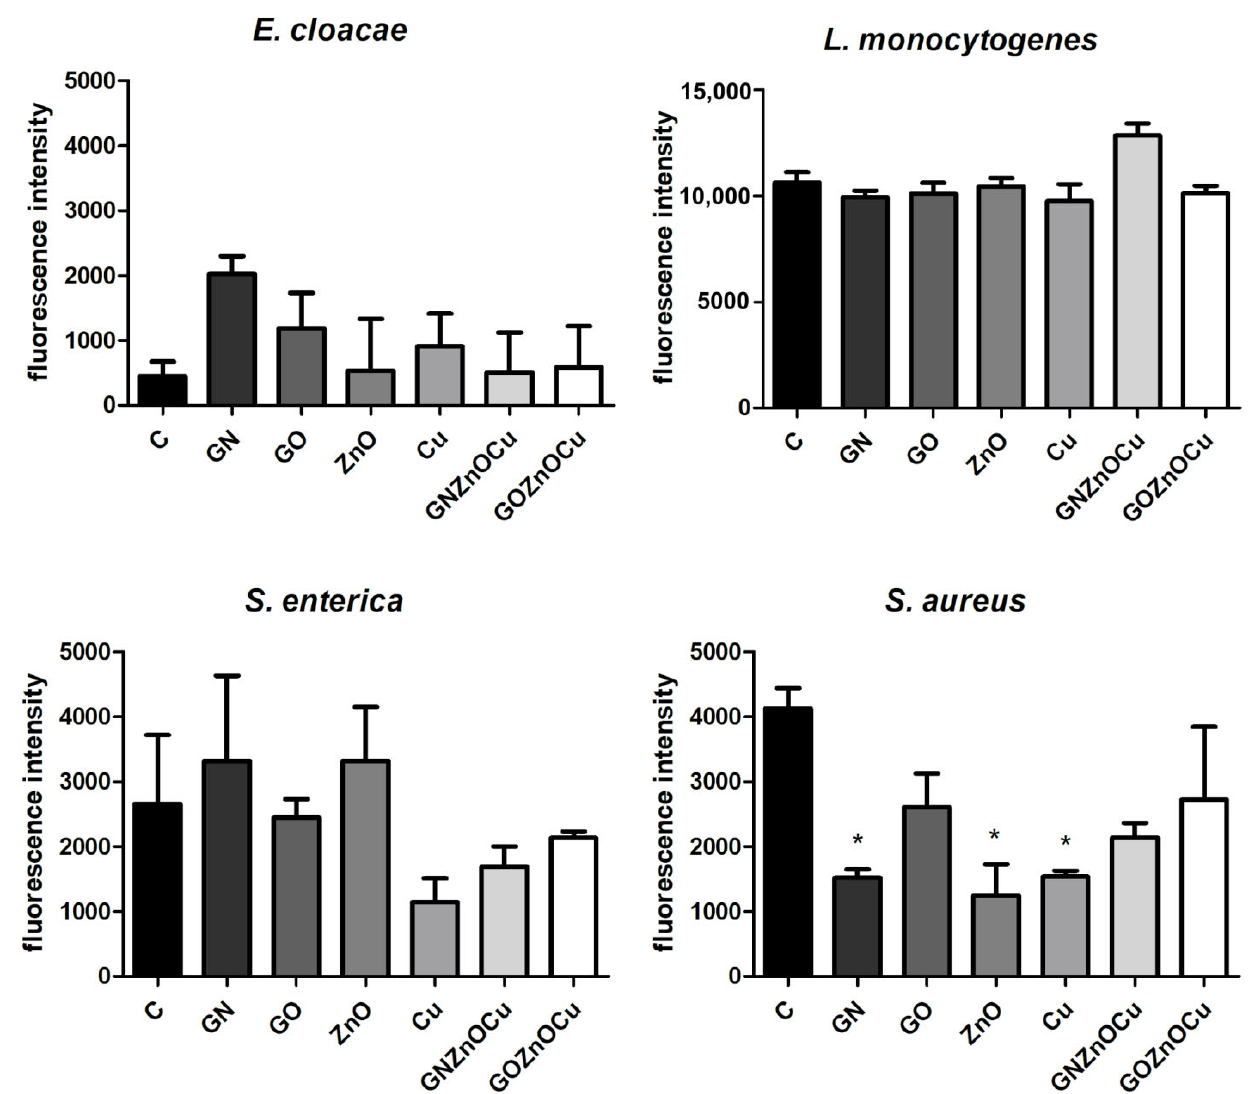
Figure 9. Intracellular pH in bacteria species after treatment with nanomaterials. C signifies the control samples, and the results are mean values ± standard deviation. “*” symbols indicate statistically significant differences in comparison to the control.